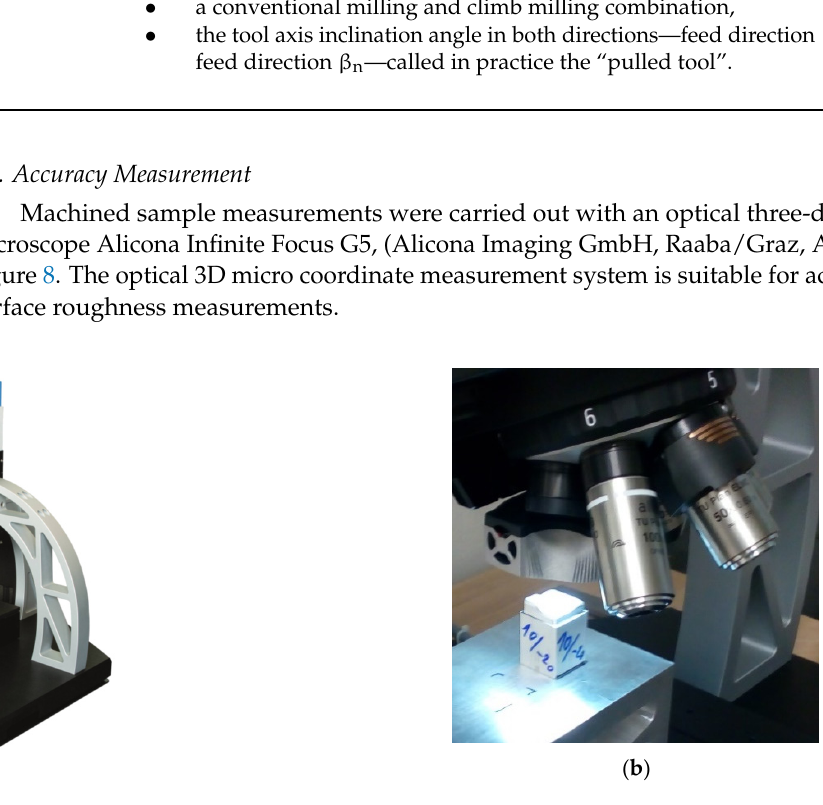
Figure 8. 3D micro coordinate measurement system ( a ) Alicona Infinite Focus G5 ( b ) sample for measurement. Real machined surface is presented in Figure 9.